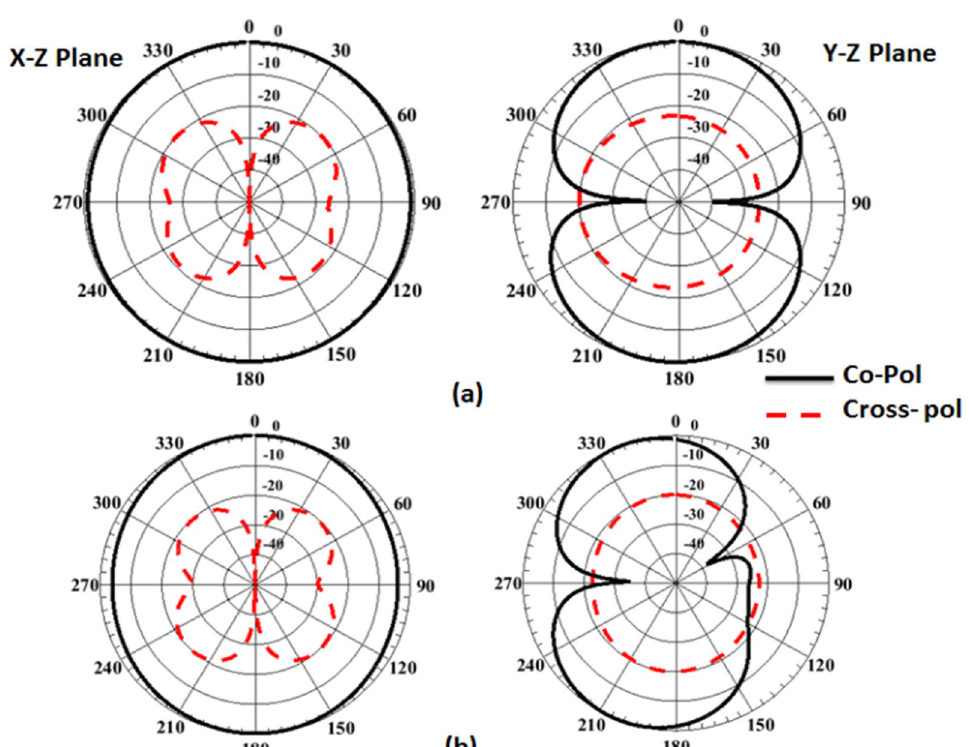
Figure 5. The Co/Cross- pol of the flexible single antenna ( a ) @ 4.5 GHz, ( b ) @8.5